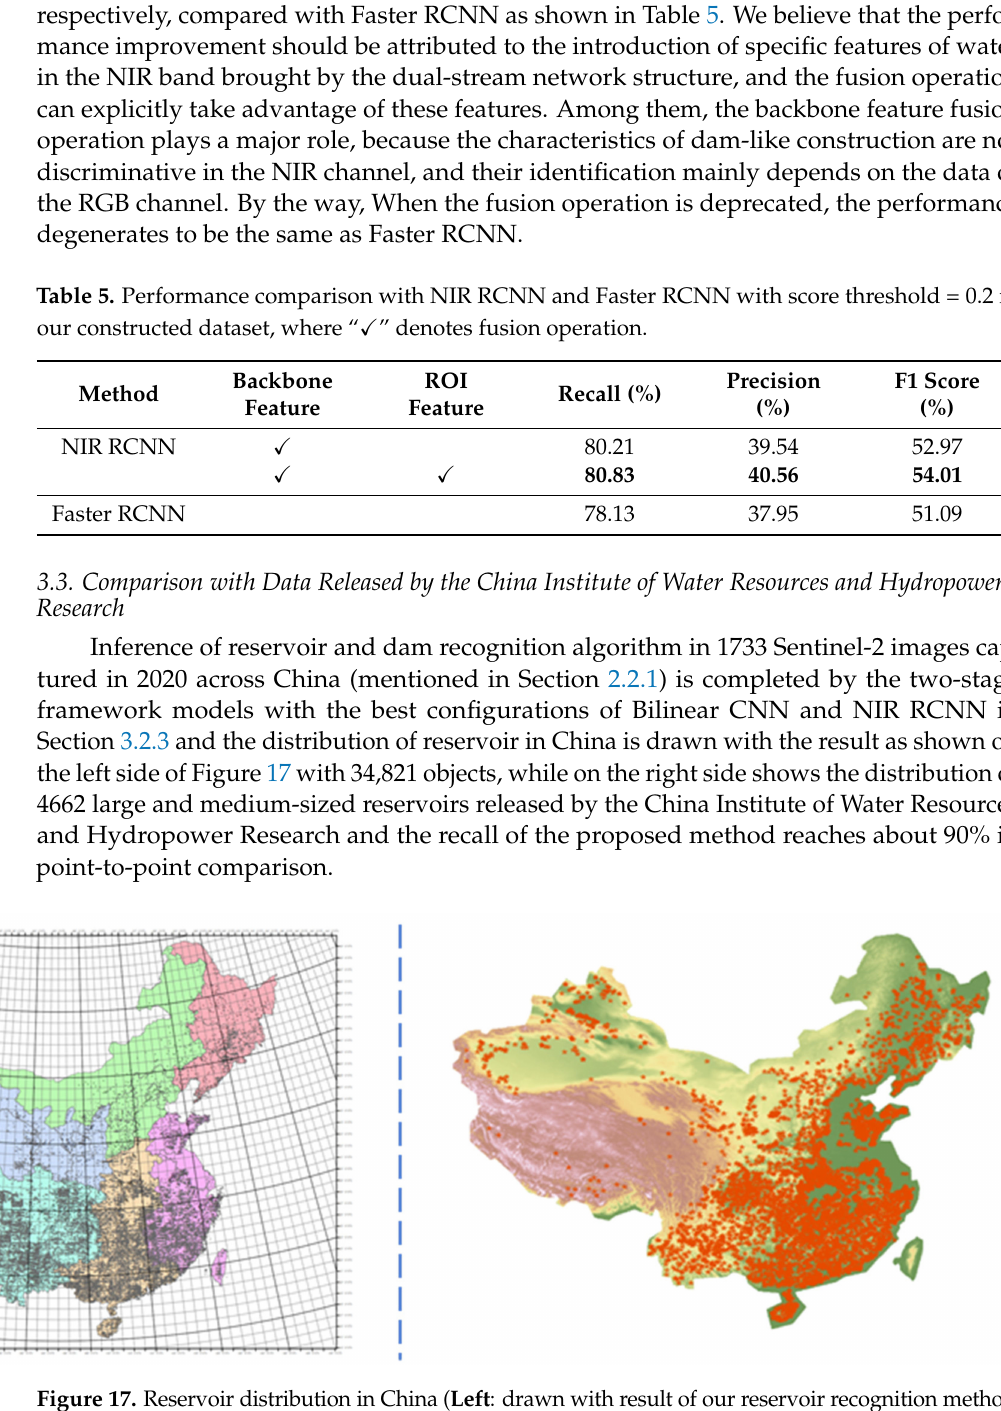
Figure 17. Reservoir distribution in China ( Left : drawn with result of our reservoir recognition method; Right : drawn with data provided by the China Institute of Water Resources and Hydropower